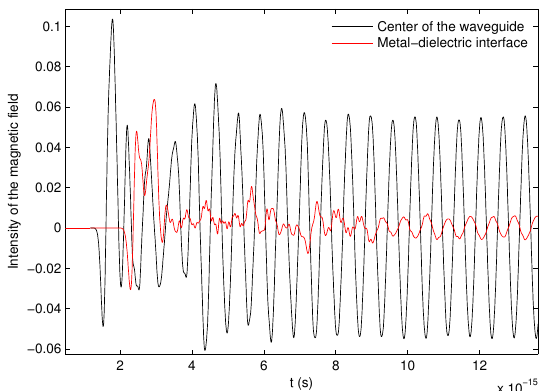
Figure 5: Temporal oscillations between the MG (in black) and the SP under the metal (in red) with a sinusoidal inci- dent